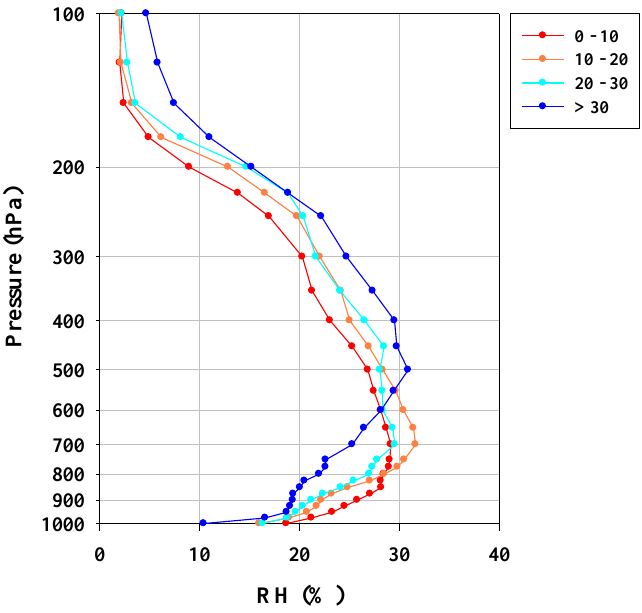
Figure 6. Vertical distribution of the standard deviation of the radiosonde relative humidity profiles classified according to the total precipitable water (TPW in kg·m −2 ) between the surface and 100 hPa.